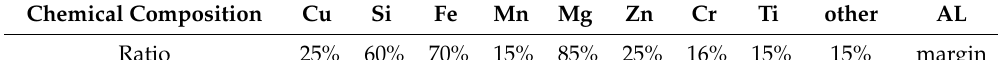
Table 2. Composition of 6061 ‐ T6 aluminum alloy.